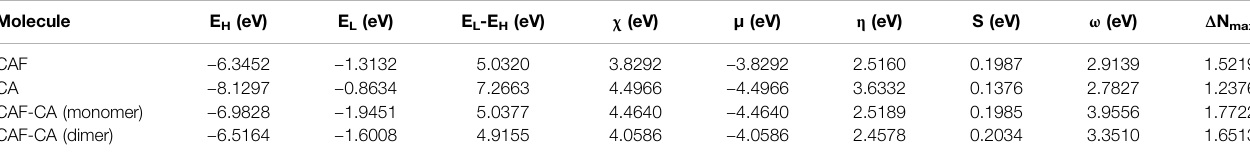
TABLE 3| Calculated E HOMO , E LUMO , energy gap (E L -E H ),chemical potential ( μ ), electro negativity( χ ), global hardness ( η ),global softness (S) and globalelectrophilicity index ( ω ) at 298.15 K for CAF, CA, monomer model and dimer model of cocrystal. Molecule